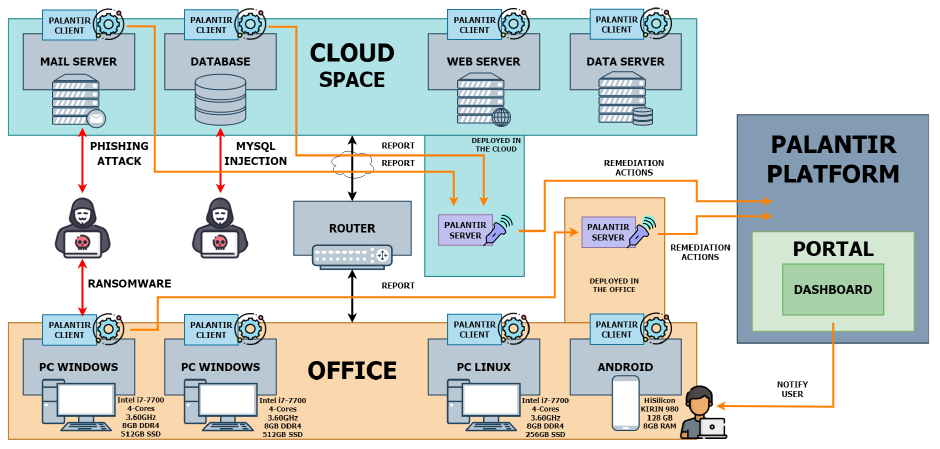
Figure 7. The testbed architecture of use case